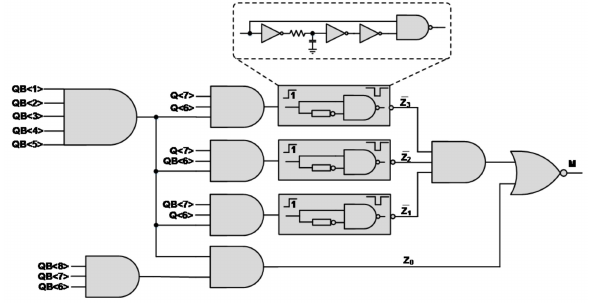
Figure 5. Z < 3:0 > and M switch control algorithm.